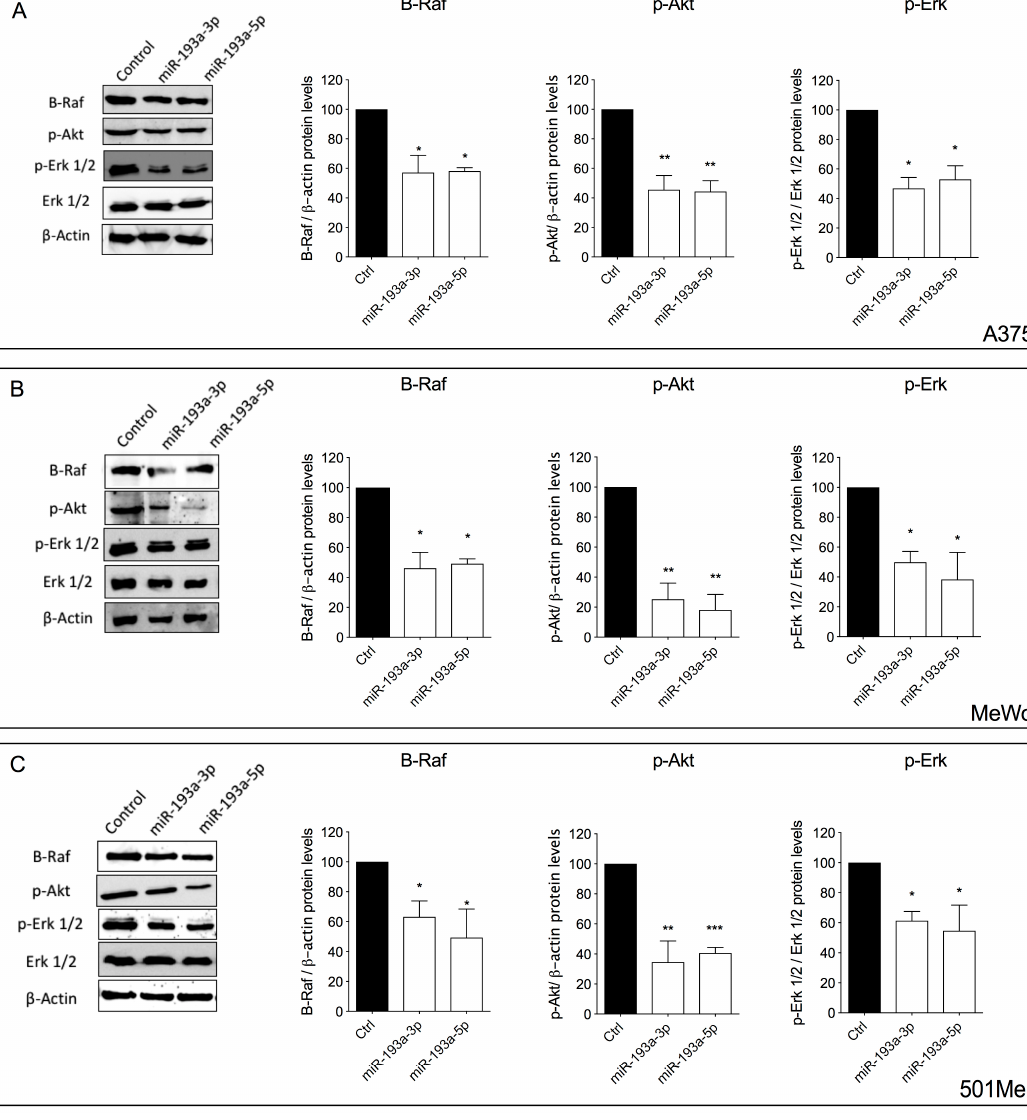
Figure 4. Ectopic over-expression of miR-193a arms reduces Akt and Ekt pathways activation. Protein expression levels of B-Raf, p-Akt, p-Erk 1/2, total Erk 1/2, and β -actin after ectopic over-expression of miR-193a-3p and miR-193a-5p in melanoma cells. Protein expression of B-Raf, p-Akt, p-Erk 1/2, total Erk 1/2, and β -actin in A375 ( A ), MeWo ( B ), and 501Mel ( C ) cell lines after 72 h of transfection with miRNA mimics was performed by Western blot analysis. Data are representative of three independent experiments ± SD performed in triplicate. One-way ANOVA followed by Dunnett’s multiple comparisons test was performed. * p < 0.05, ** p < 0.01, *** p < 0.001, compared to corresponding control.